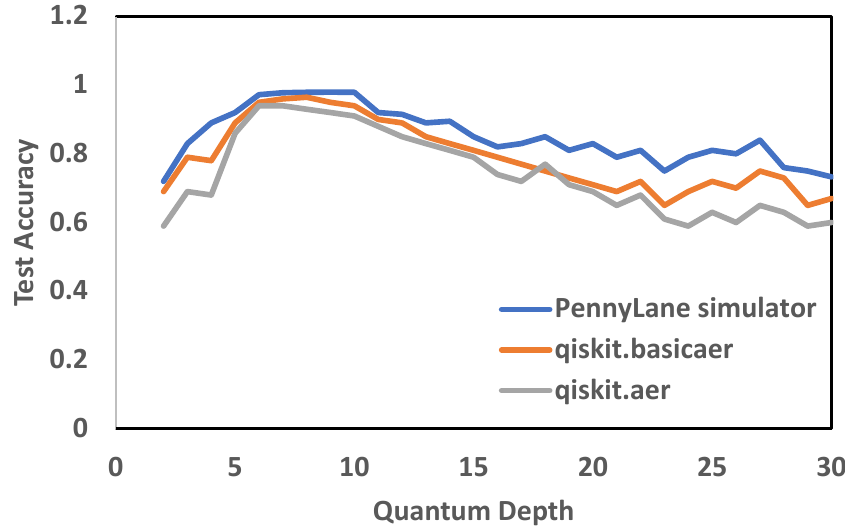
Figure 13. Test accuracy plot with respect to quantum depth for the classical–quantum neural network. Table 7. Comparison of proposed quantum transfer learning method with existing state-of-the-art